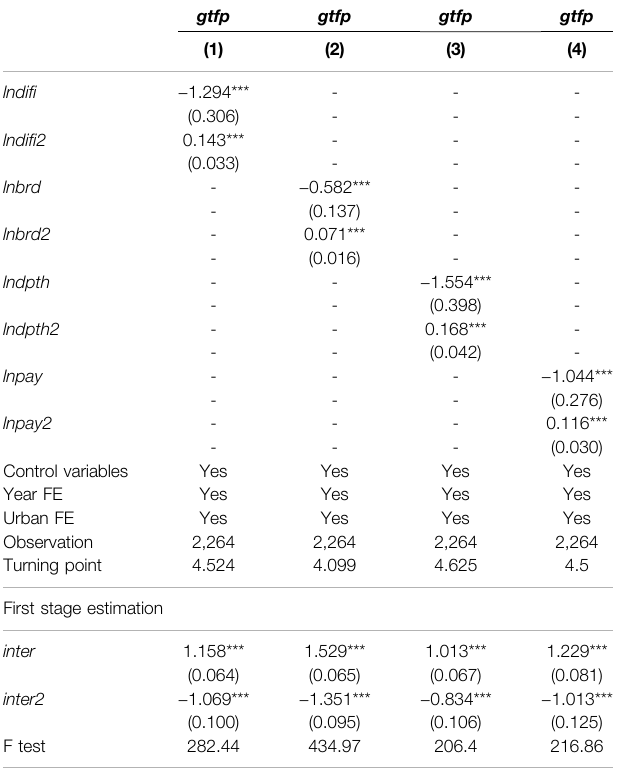
TABLE 10 | Estimation results of